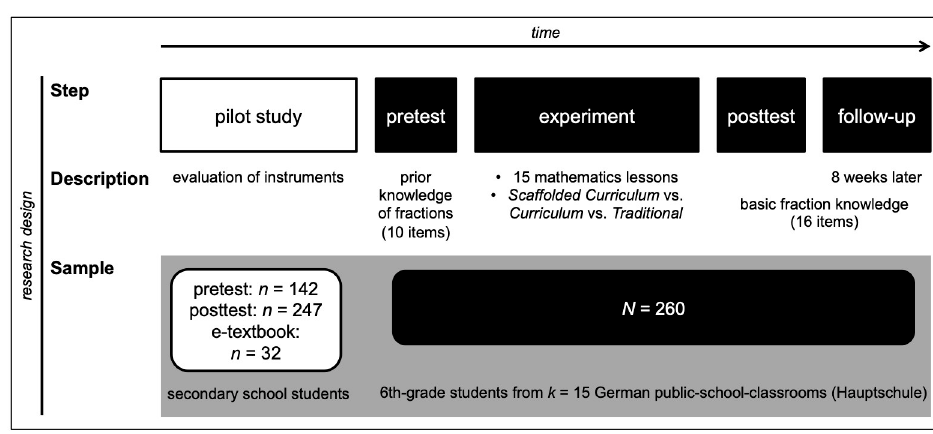
Fig 2. Overview of the study